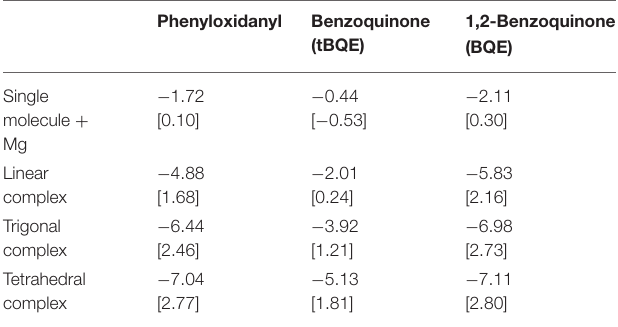
TABLE 1 | Formation energies (eV) [theoretical voltages (V) vs. Mg2 + /Mg] for systems shown in Figure 6